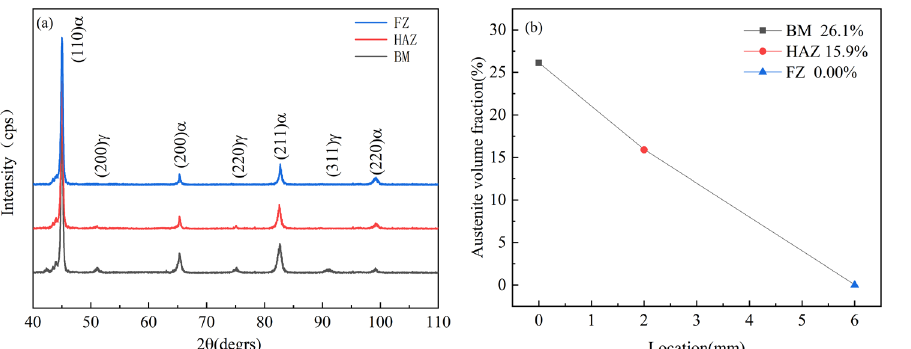
Figure 3. Residual austenite content at different locations of the joint: (a) X-ray diffraction pattern; (b) volume fraction of residual